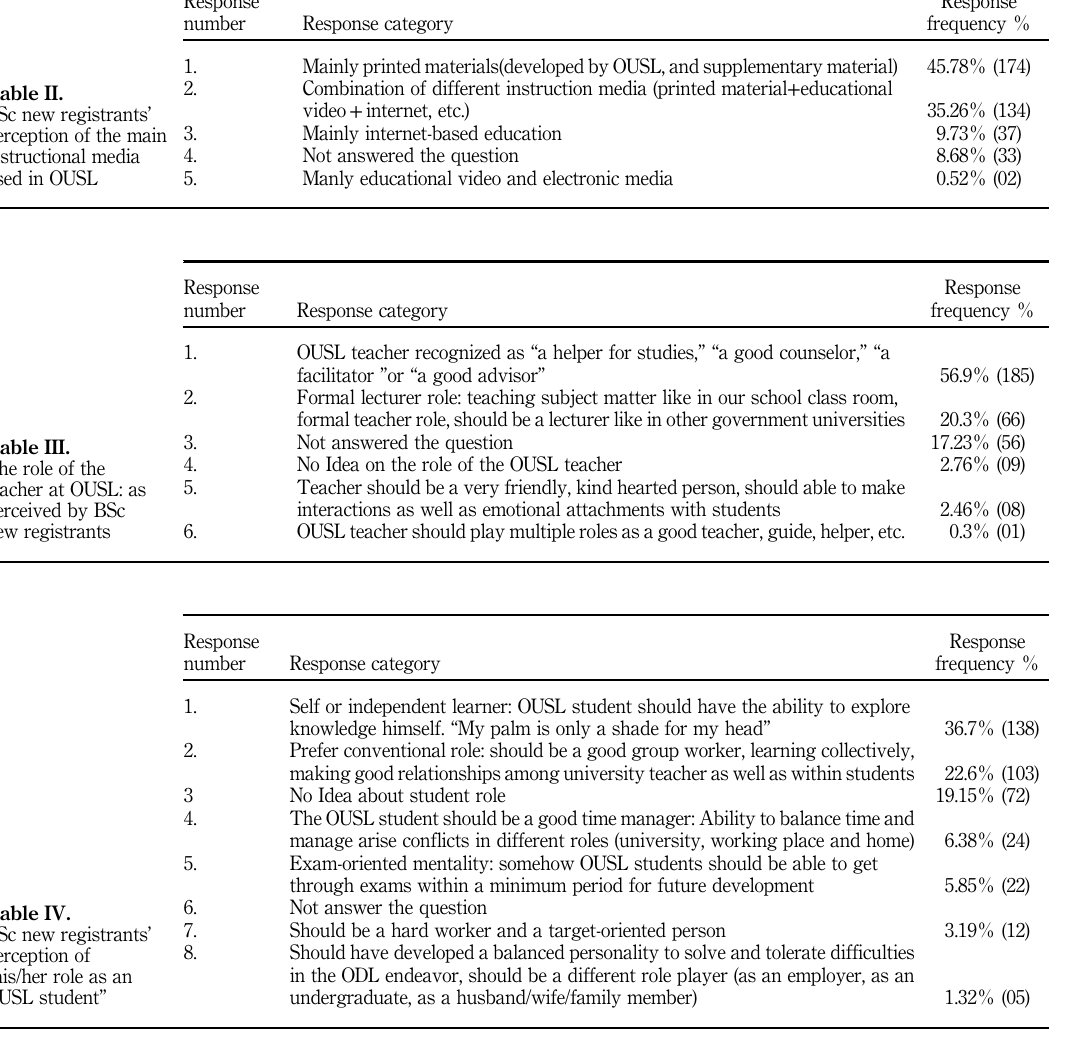
perception of “ his/her role as an